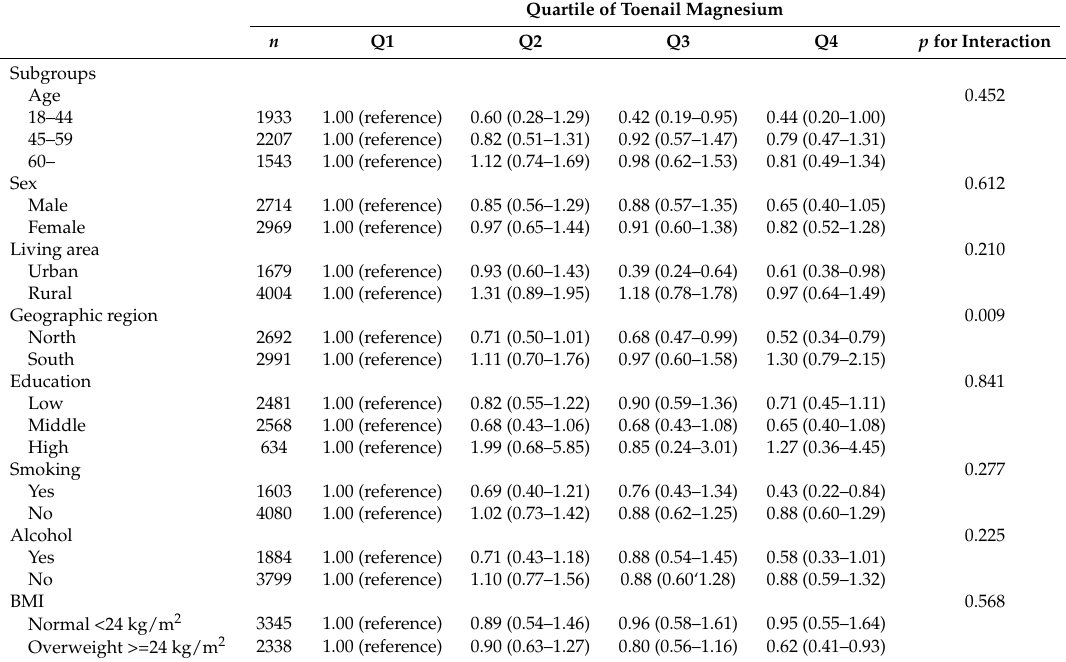
Table 4. ORs for type 2 diabetes comparing the highest to the lowest quartile of toenail magnesium in selected subgroups.